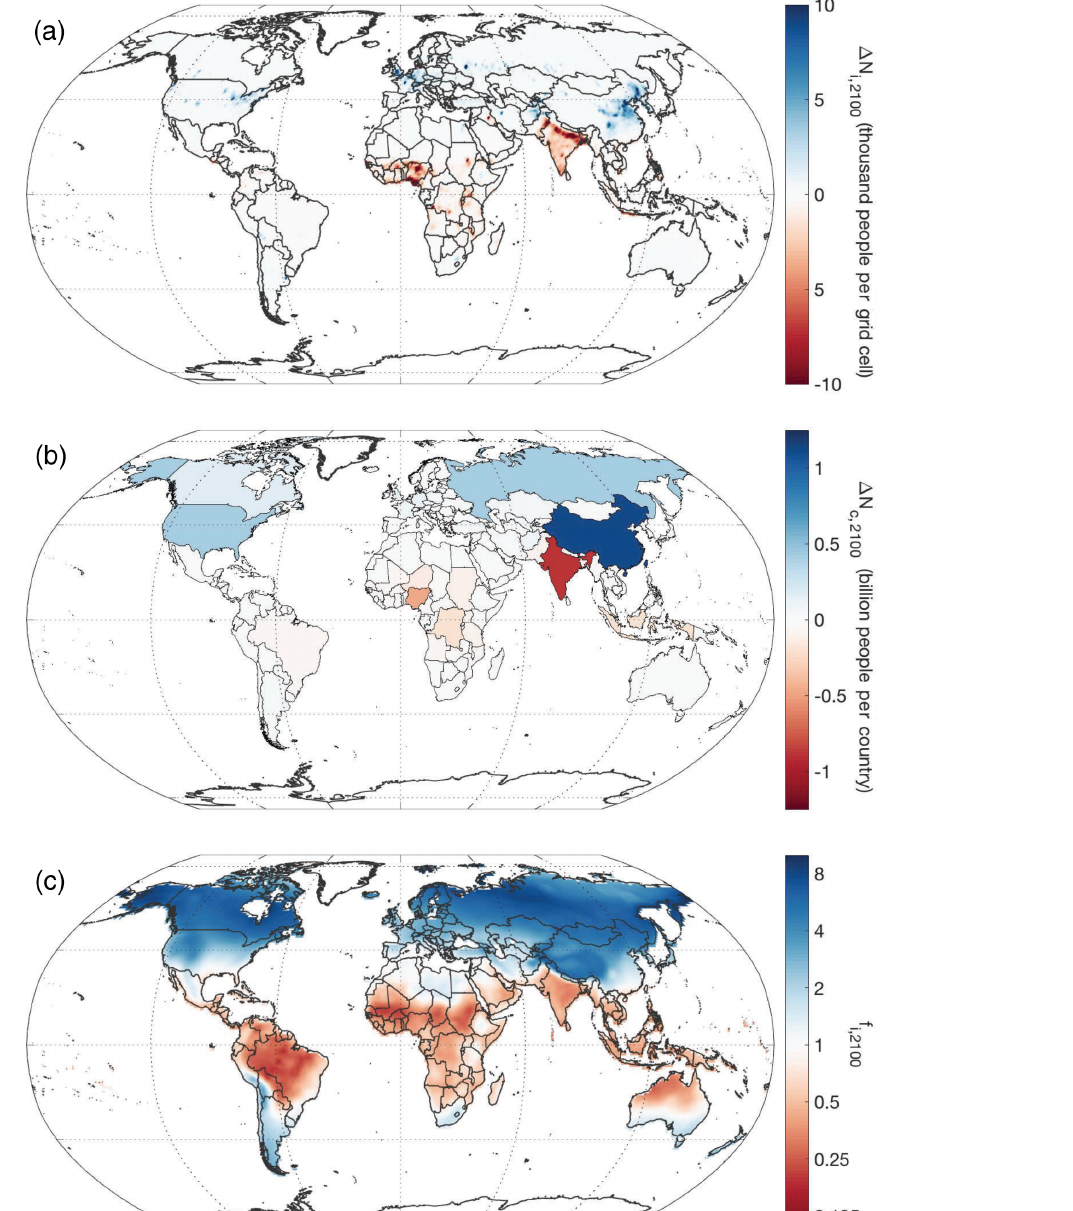
Figure 1. The number of people for whom climate change is projected to provide additional incentive to migrate under RCP8.5 per 1 ◦ × 1 ◦ grid cell: (a) (cid:49)N i, 2100 (in thousands of people per grid cell) and (b) (cid:49)N c, 2100 (in billions people per country). (c) The fractional change in the population that would be required to offset the influence of climate change on the relative attractiveness of living in a particular location for the year 2100 ( f i, 2100 ) under scenario RCP8.5 . To isolate the effect of climate change on incentives to migrate, all factors are held constant, except for climate and country-level population. Of course, many other factors influence migration